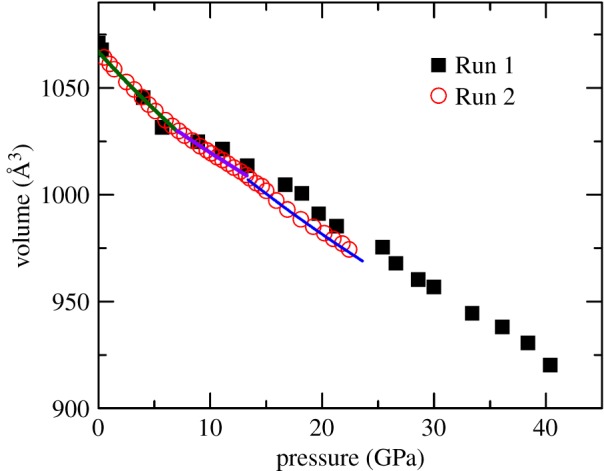
The P-V relationship of Gd1.5Ce0.5Ti2O7. The black squares are the data of run 1, with silicone oil loaded as the pressure medium. The red circles are data from run 2, whose pressure medium is noble gas argon. The P-V curves from three regions are shown in different colours: the dark green curve indicates p < 6.5 GPa, the purple curve shows 6.5 GPa < p < 13.5 GPa and the blue curve is p > 13.5 GPa.